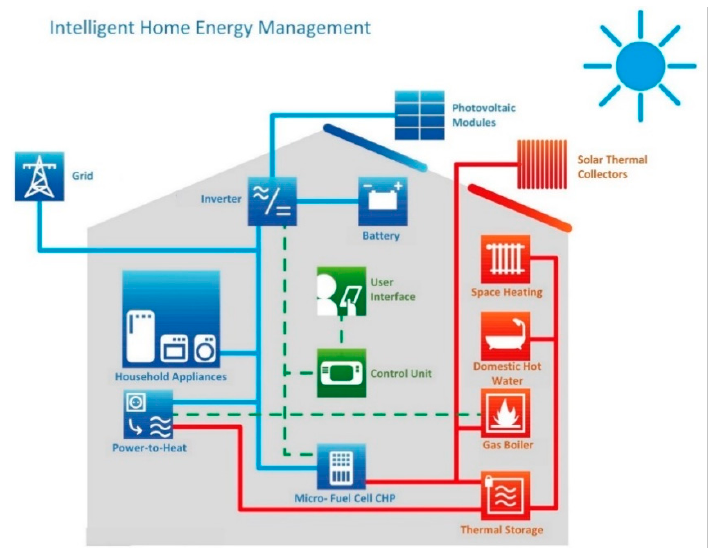
Figure 1. Overview of the energy system built up as demonstrator during iHEM project [30].